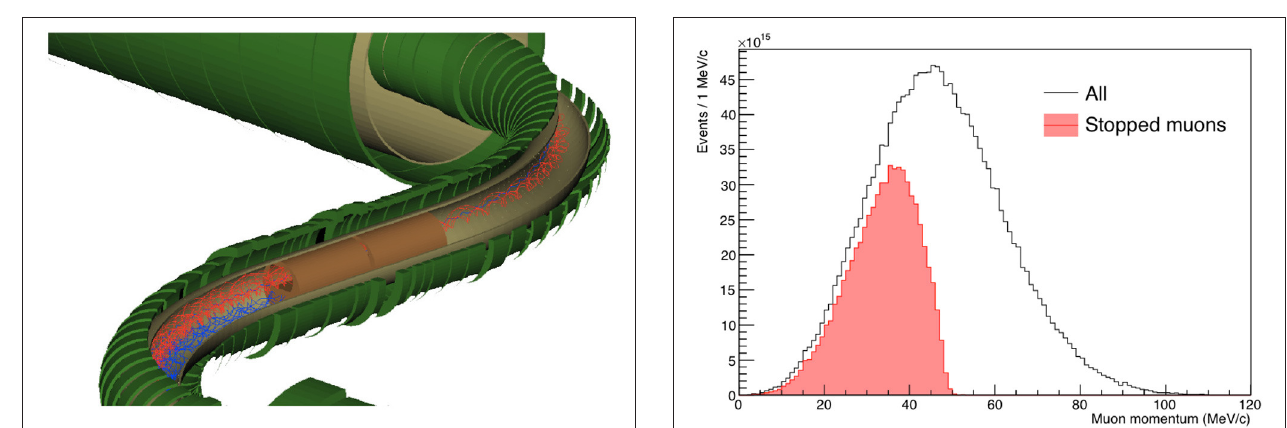
FIGURE 5 | Momentum distribution of all muons reaching the stopping target together with those that do stop, normalized to the standard exposure of 3.6 × 10 20 protons-on-target. From the Mu2e